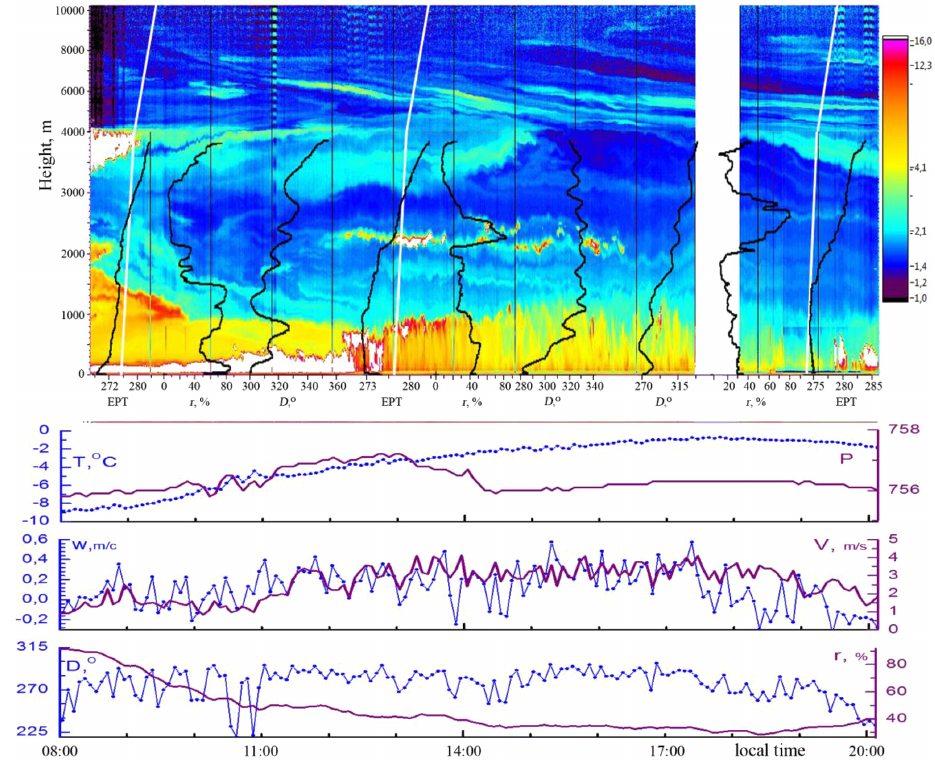
Figure 11. The aerosol structure on 3 April 2013. White lines show the ascent sonde